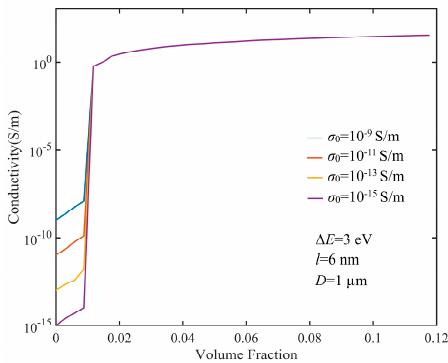
ff erent polymer